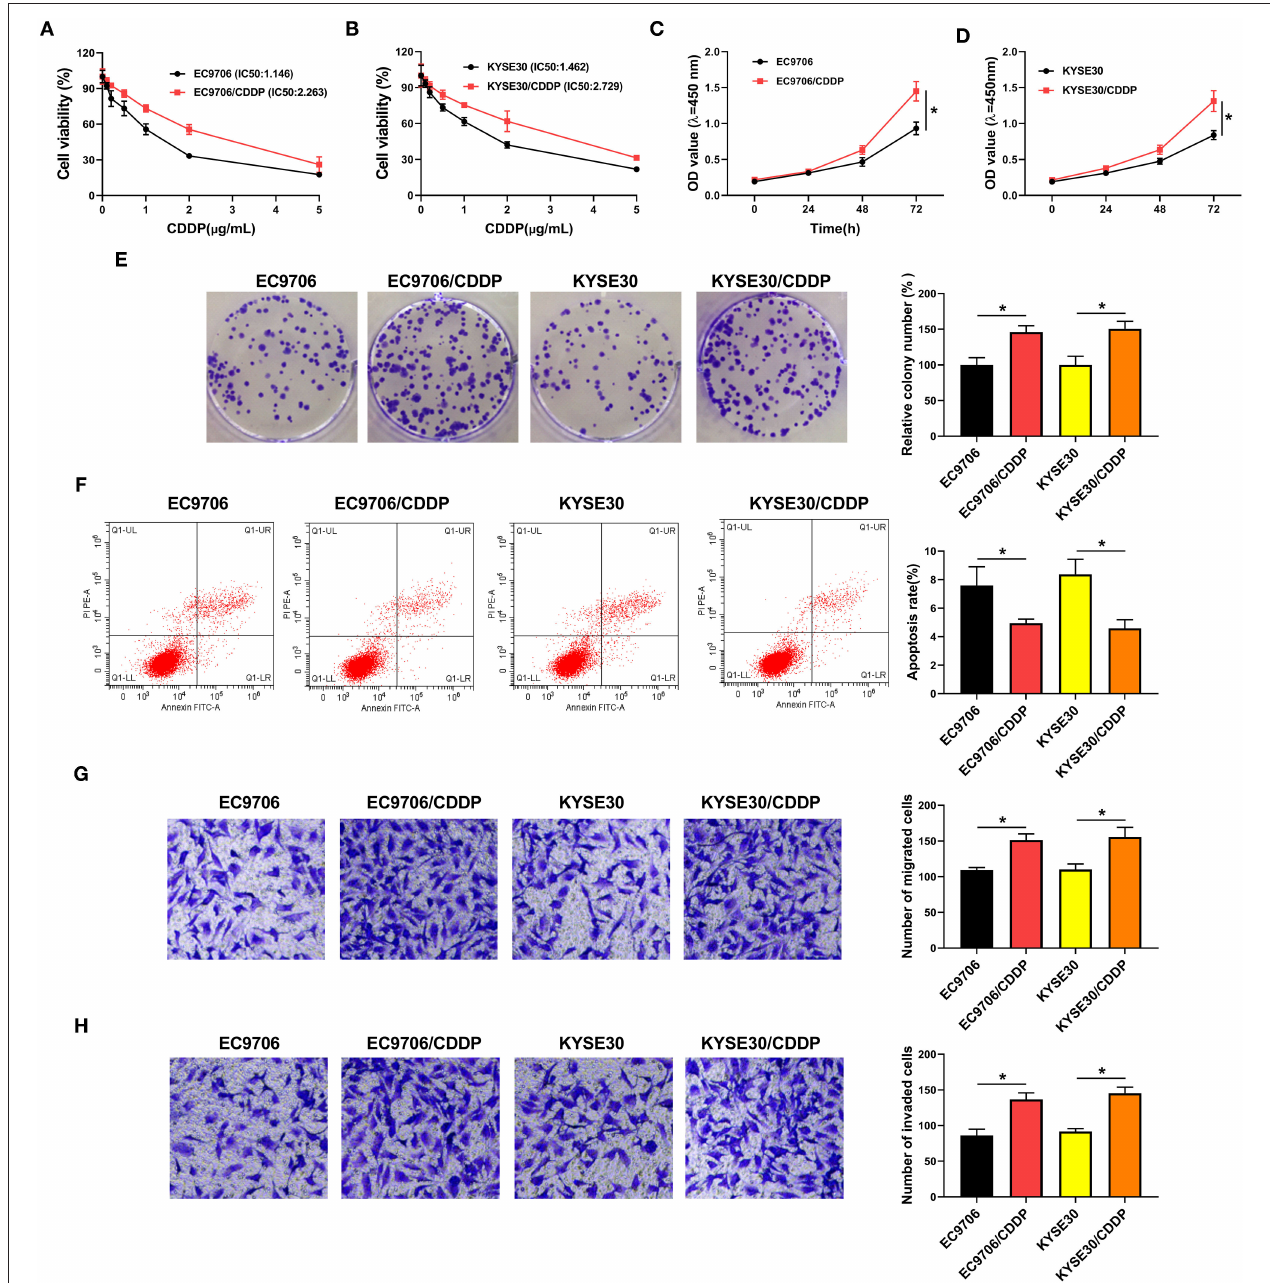
FIGURE 1 | Characterization of CDDP-resistant esophageal cancer cells. (A,B) CCK-8 assay was applied to detect cell viability and IC50 values in parental esophageal cancer cells (EC9706 and KYSE30) and CDDP-resistant esophageal cancer cells (EC9706/CDDP and KYSE30/CDDP). (C,D) Proliferation was assessed in EC9706, EC9706/CDDP, KYSE30, and KYSE30/CDDP cells by CCK-8 assay. (E,F) Cell colony formation and flow cytometry assays were performed to assess the clone number and apoptosis rate in EC9706, EC9706/CDDP, KYSE30, and KYSE30/CDDP cells. (G,H) Transwell assays were conducted to measure the abilities of migration and invasion in EC9706, EC9706/CDDP, KYSE30, and KYSE30/CDDP cells. * P < 0.05.